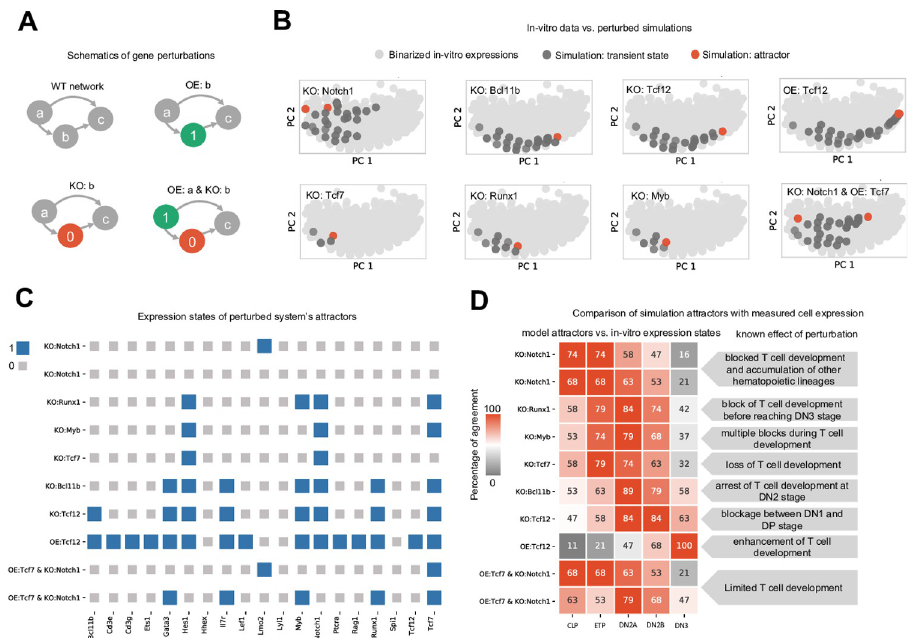
Fig 4. Testing the known effect of eight gene perturbations on in silico developmental trajectories. (A) Schematic of performed gene perturbations. In OE, the gene is always expressed (represented with 1) and in KO the gene is always silent (represented with 0). (B) PCA plot of the simulated developmental trajectories under perturbed conditions are overlaid on the binarized scRNA-seq. The perturbations include KO of Notch1 , KO of Tcf7 , KO of Bcl11b , KO of Runx1 , KO of Tcf12 , KO of Myb , OE of Tcf12 and the double perturbation, OE of Tcf7 and KO of Notch1 at the same time. (C) Expression states of the model attractors under perturbations. Genes that are expressed (1) and not expressed (0) are represented with blue and grey squares, respectively. (D) Percentage of similarity between the model attractors under perturbations (vertical axis) and the binarized expressions of CLP, ETP, DN2A, DN2B, and DN3A cells (horizontal axis) [38] (left). Description of known effect of the gene perturbation on T-cell development